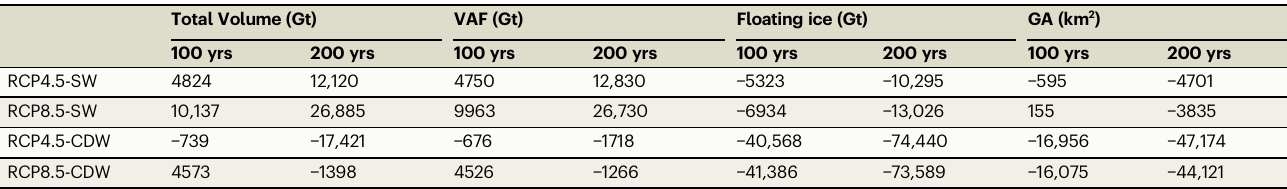
Table 1 | Summary of total ice volume, volume of ice above fl otation (VAF), volumeof fl oating ice and grounded area relative to the baseline case with constant